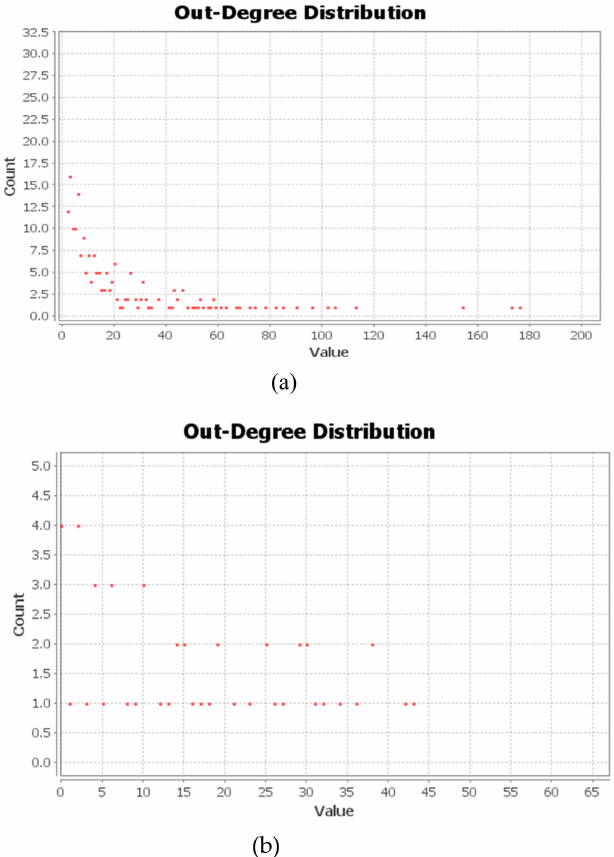
Figure 7. Degree Distribution of Social Media Network (out-degree): ( a ) Tianjin Explosion Network; ( b ) Typhoon Pigeon